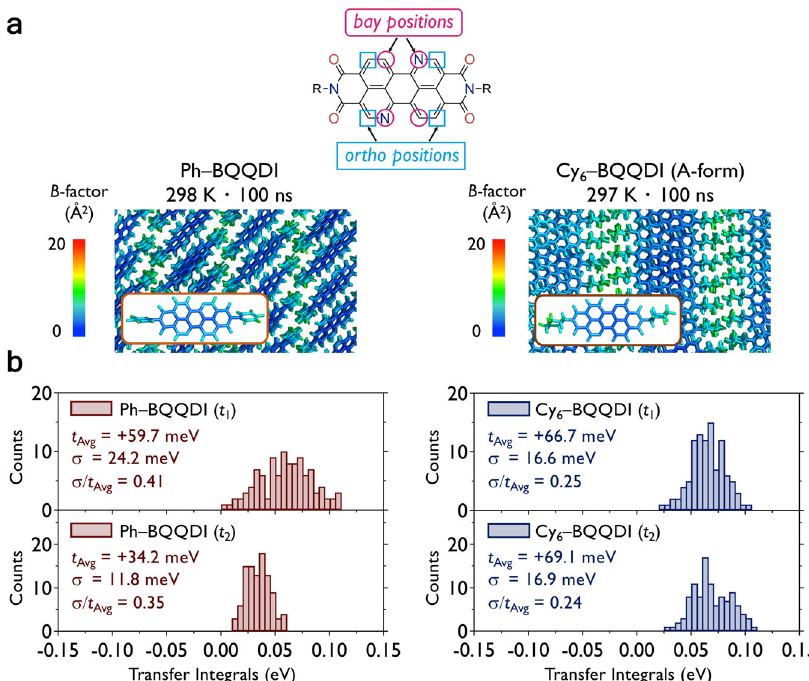
Fig. 4 Molecular dynamics simulations of Ph – BQQDI and Cy 6 – BQQDI. a Ortho/bay positions of BQQDI and color-coded B -factor (Å 2 ) distributions obtained from the trajectories during the last 10 ns of a 100-ns MD simulation in the NTP ensemble (the magnitude of B -factors is represented by the color-coded scale bar ranging from blue (small value) to red (large value)). b Variant t 1 and t 2 distributions and standard deviations ( σ ) calculated from 100 pairs of adjacent dimers, revealing the magnitude of the dynamic